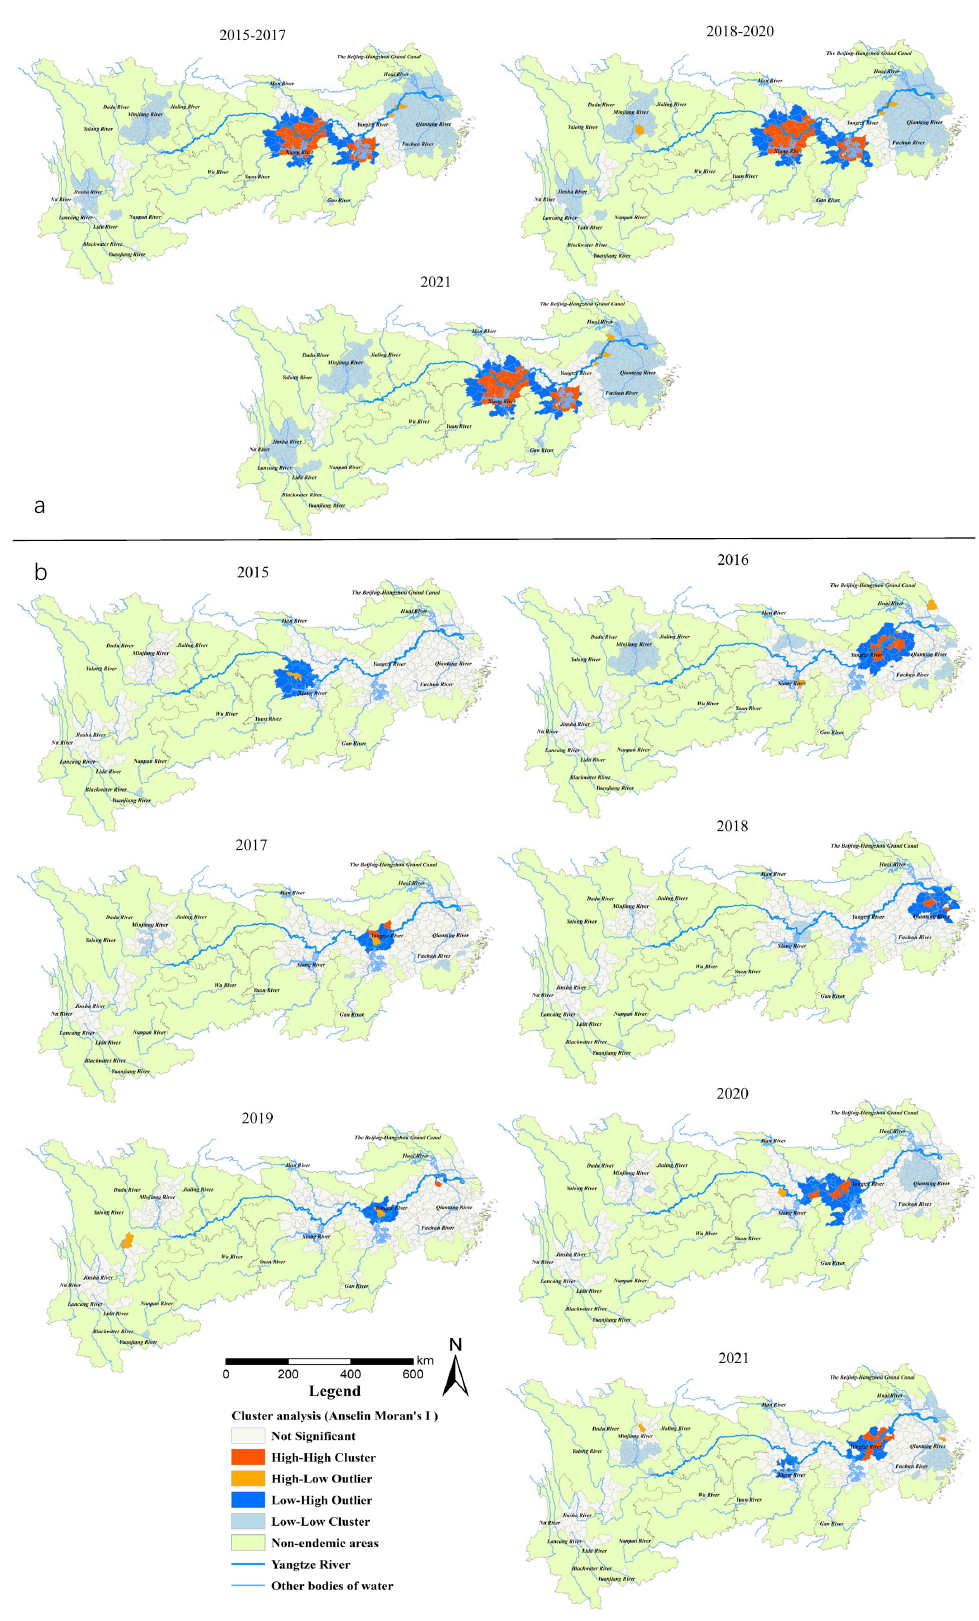
Figure 3. ( a ) Total area of the snail habitats; ( b ) emerging snail habitats. Clusters and outlier areas of snail habitats in the endemic areas in the YEB,